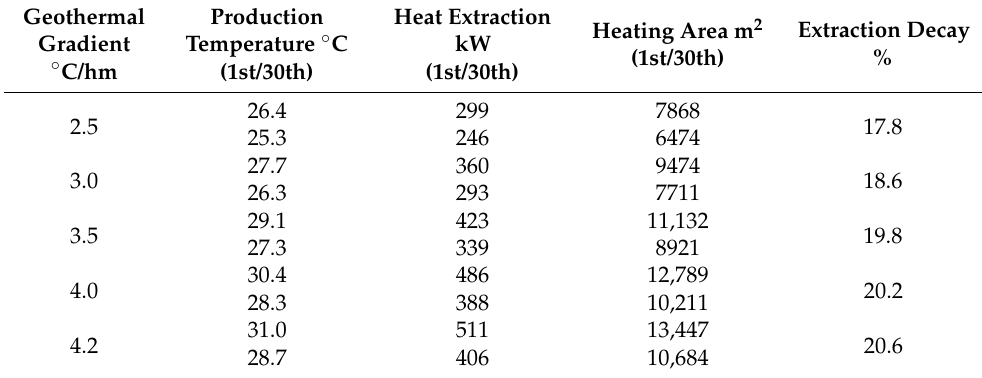
Table 3. Simulation results of M1 well under different geothermal